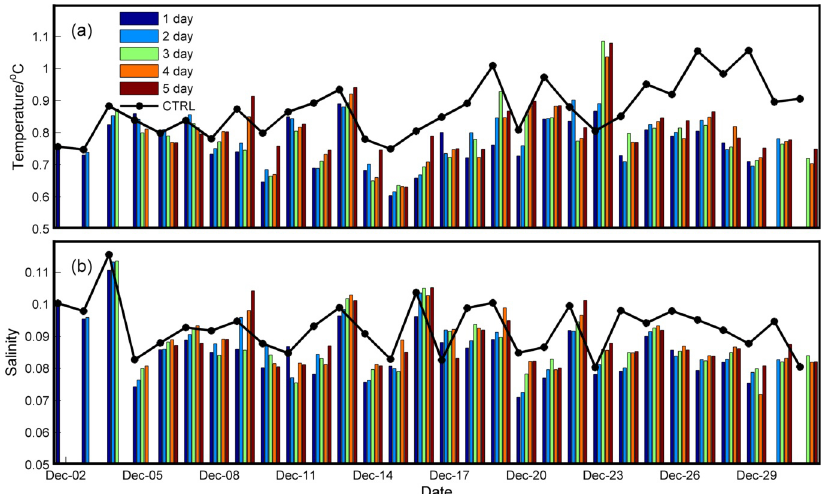
Figure 14. Temporal evolution of temperature (a) and salinity (b) RMSE with 5-day forecasting experiment: dark blue bar represents the RMSE of first-day forecast, the light blue bar represents the RMSE of the second-day forecast, the emerald bar represents the RMSE of third-day forecast, the orange bar represents the RMSE of fourth-day forecast, the red bar represents the RMSE of fifth-day forecast and the solid line represents the RMSE of CTRL